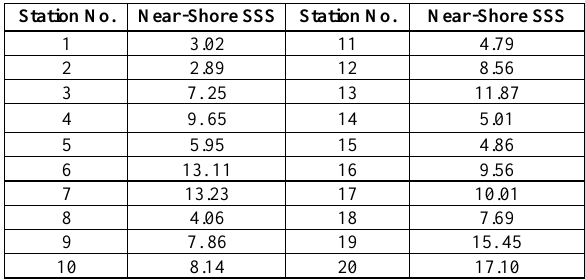
Figure 7 . Value of SSS estimated from Landsat 9 OLI versus in-situ